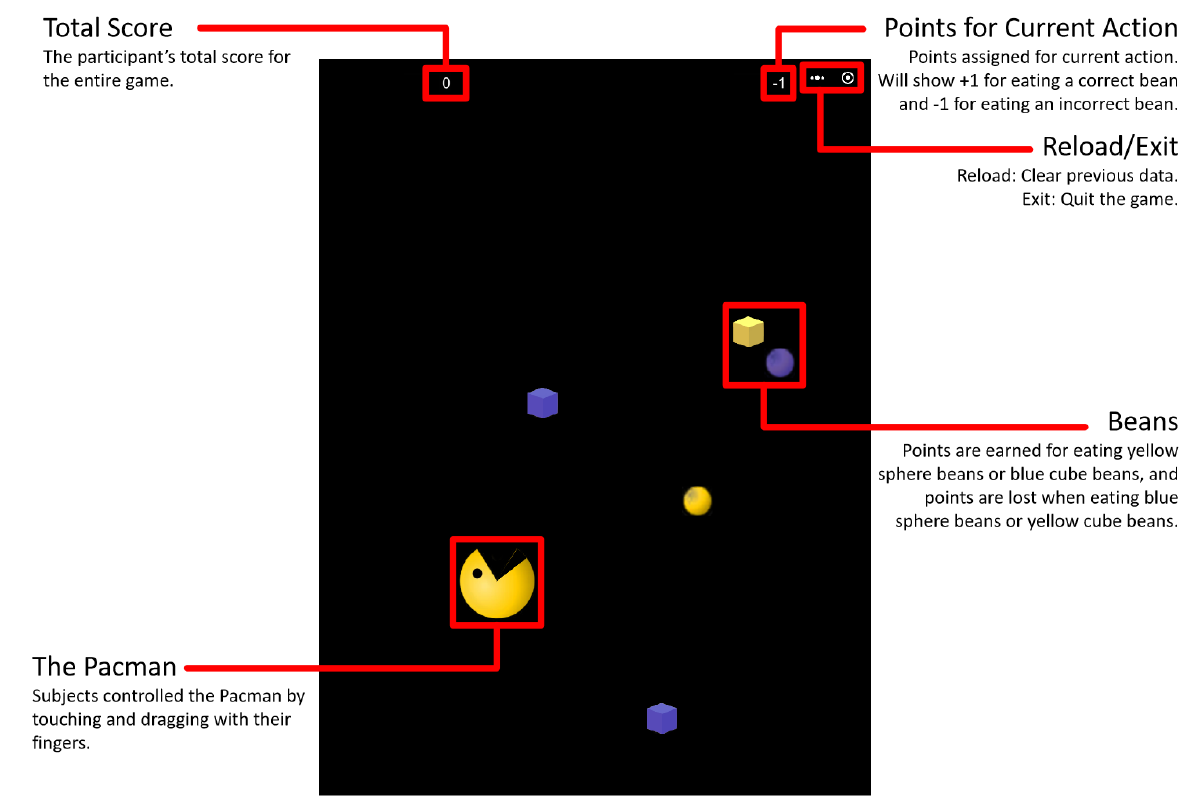
Figure 1. Interface of the touchscreen video game. Note. Screenshot of the video game interface on a 10.2-inch touchscreen. Red boxes and lines are not part of the interface.